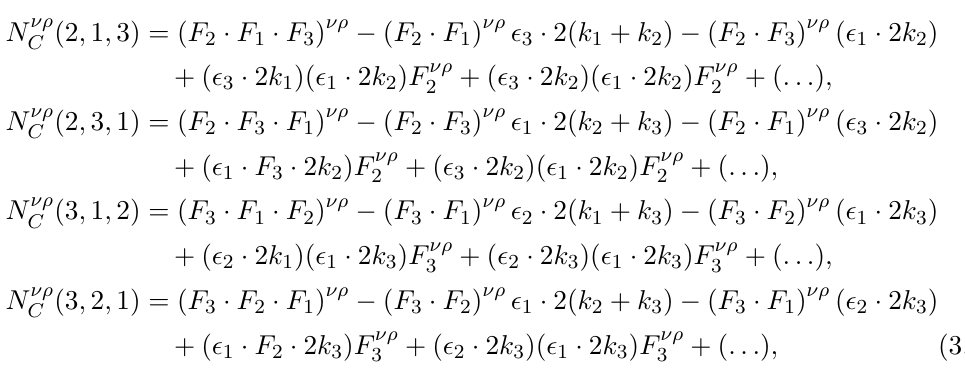
Figure 7 . Possible structures of type-C graphs with three on-shell